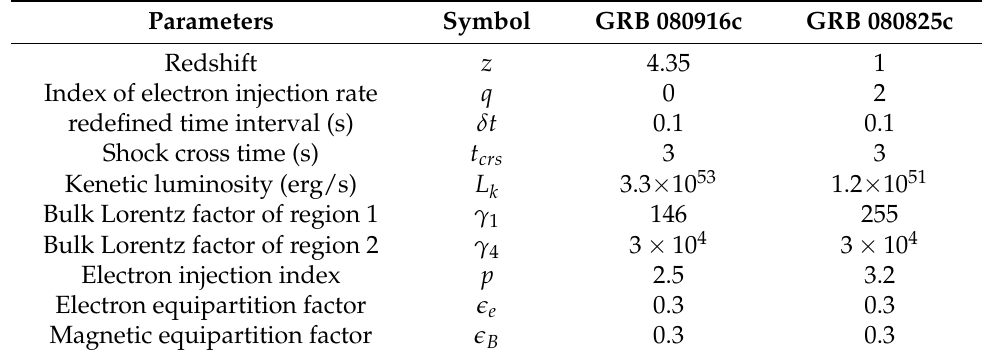
Figure 6. The time-averaged spectrum to fit the interval “a” of GRB 080825c. The black points are selected from the Band function with the low-energy photon index α = − 0.76 ± 0.05, the high-energy photon index β = − 2.54 + 0.11 − and the peak energy E p = 291 + 25 − keV provided in Ref. [44], which are 22 0.17 precise enough to present the tendency of the actual GRB emission. This spectral duration is from 0.0s to 2.7s and we fit it by adopting the time-averaged spectrum from t = 0 s to t = 3 s ( t max ≤ t crs ). The fitting parameters are listed in Table 1. Table 1. The parameters adopted to fit the spectra of GRB 080916c and GRB